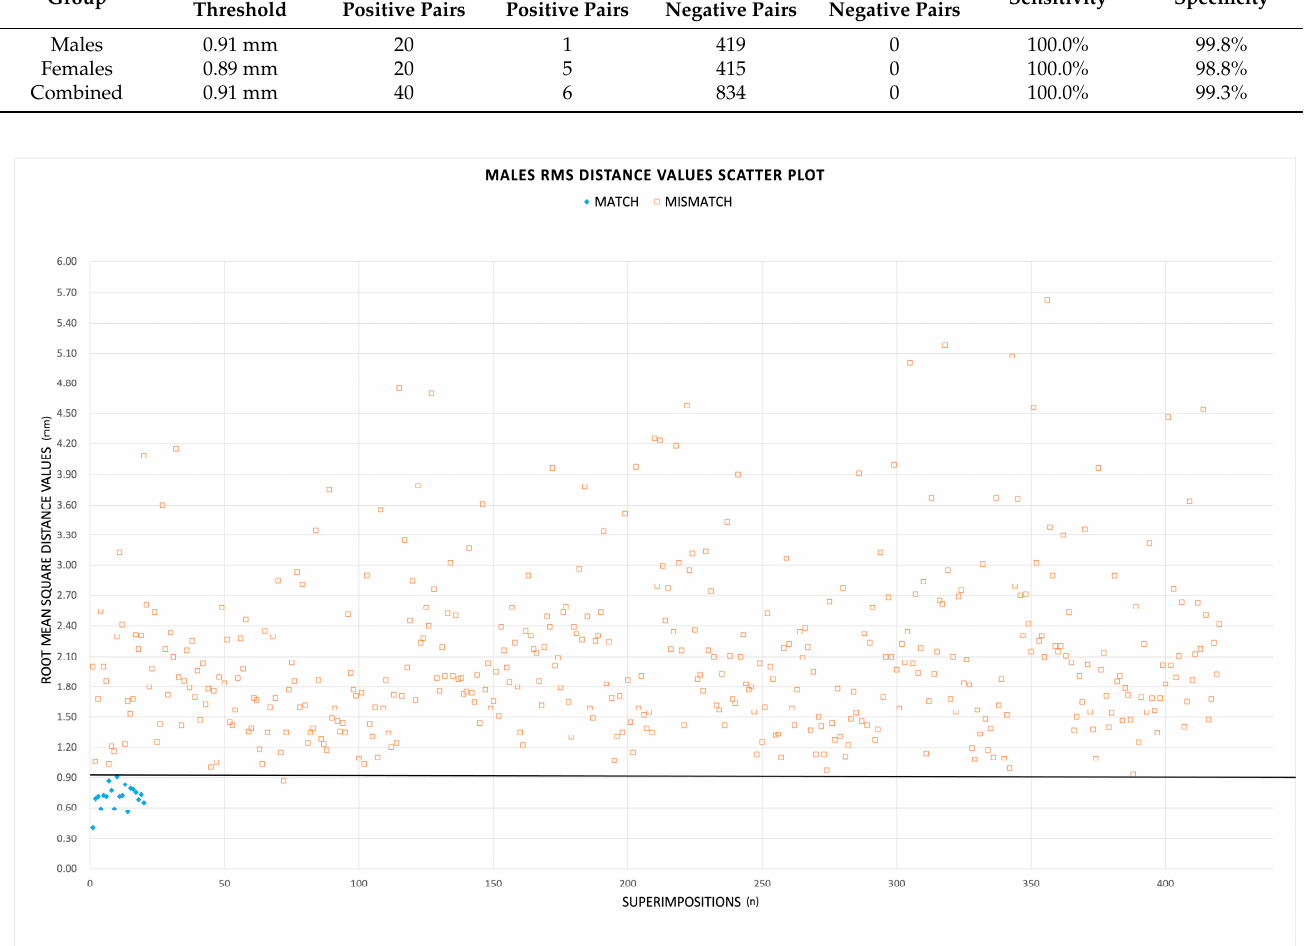
Figure 2. Scatter plot of the RMS distance values for males. The blue diamonds are the 20 RMS distance values of true pair matches, whereas the orange squares are the mismatches. The black line represents the threshold of 0.91 mm.